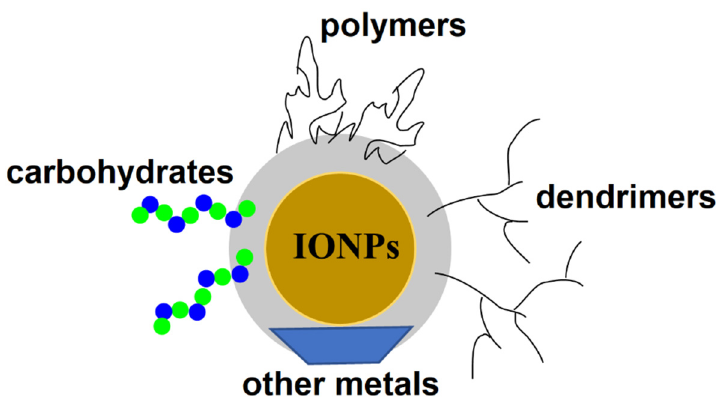
Figure 6. Schematic illustration of the surface functionalization of IONPs with various biomaterials, including polymers, dendrimers, carbohydrates, and other metals.